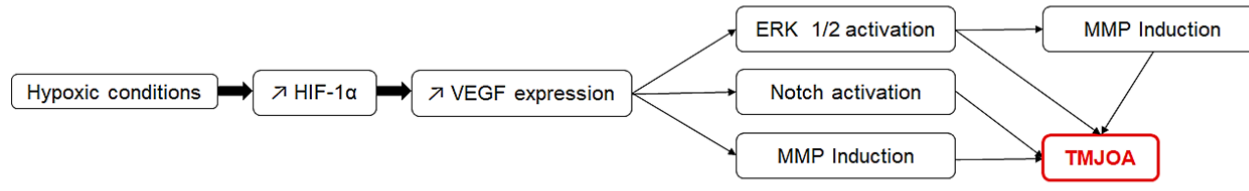
Figure 3. The signaling pathways that may be involved in TMJOA and their possible synergistic action.